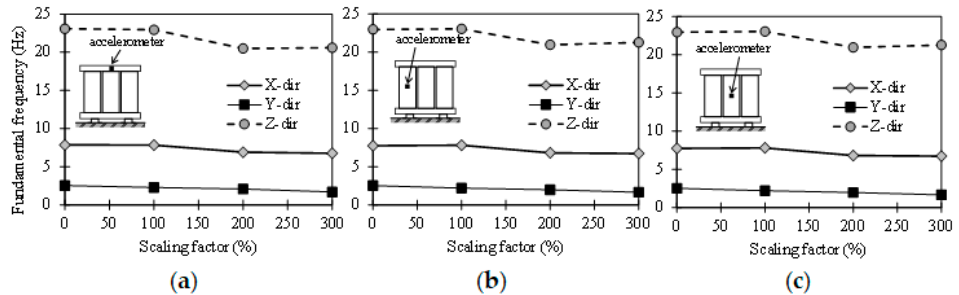
Figure 9. Variation of fundamental frequency of test specimen evaluated based on acceleration data at different locations. ( a ) At top beam; ( b ) At left coil; ( c ) At center coil.